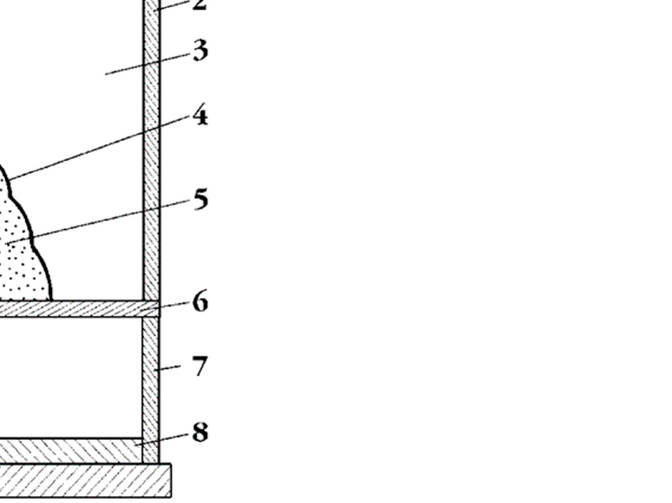
Figure 1. Outdoor explosive accelerator [39] : 1—initiator, 2—facing, 3—charge, 4—cumulative lens, 5—powder mixture, 6—plate-cartridge base, 7—adjusting support, and 8—sample.